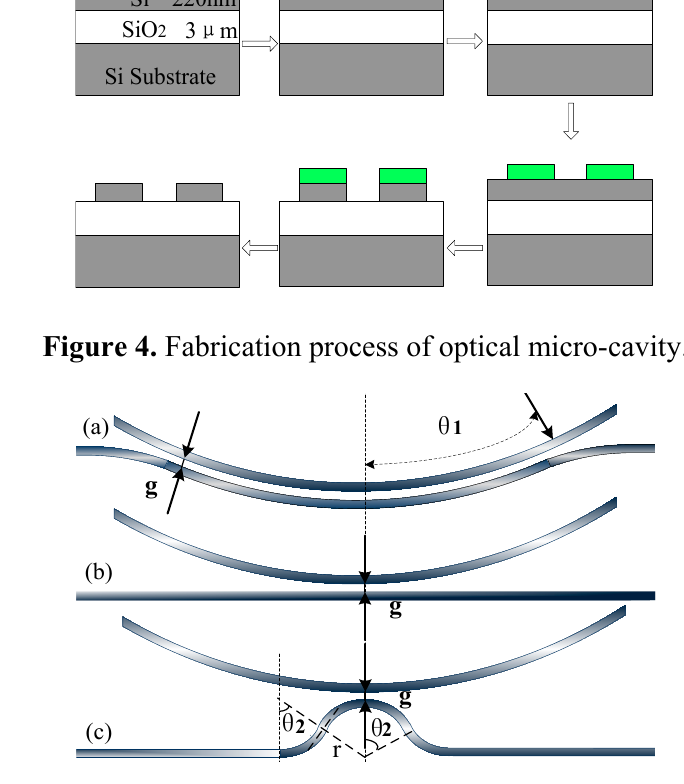
Figure 5. Schematic of coupling regions: ( a ) Concentric-coupled. ( b ) Straight-coupled. ( c )